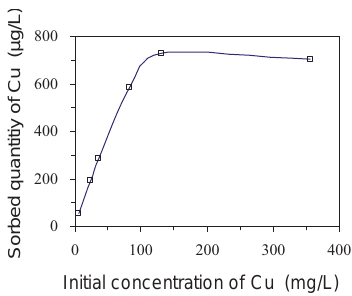
FIG. 1. Sorption of Cu in different initial concentrations of copper